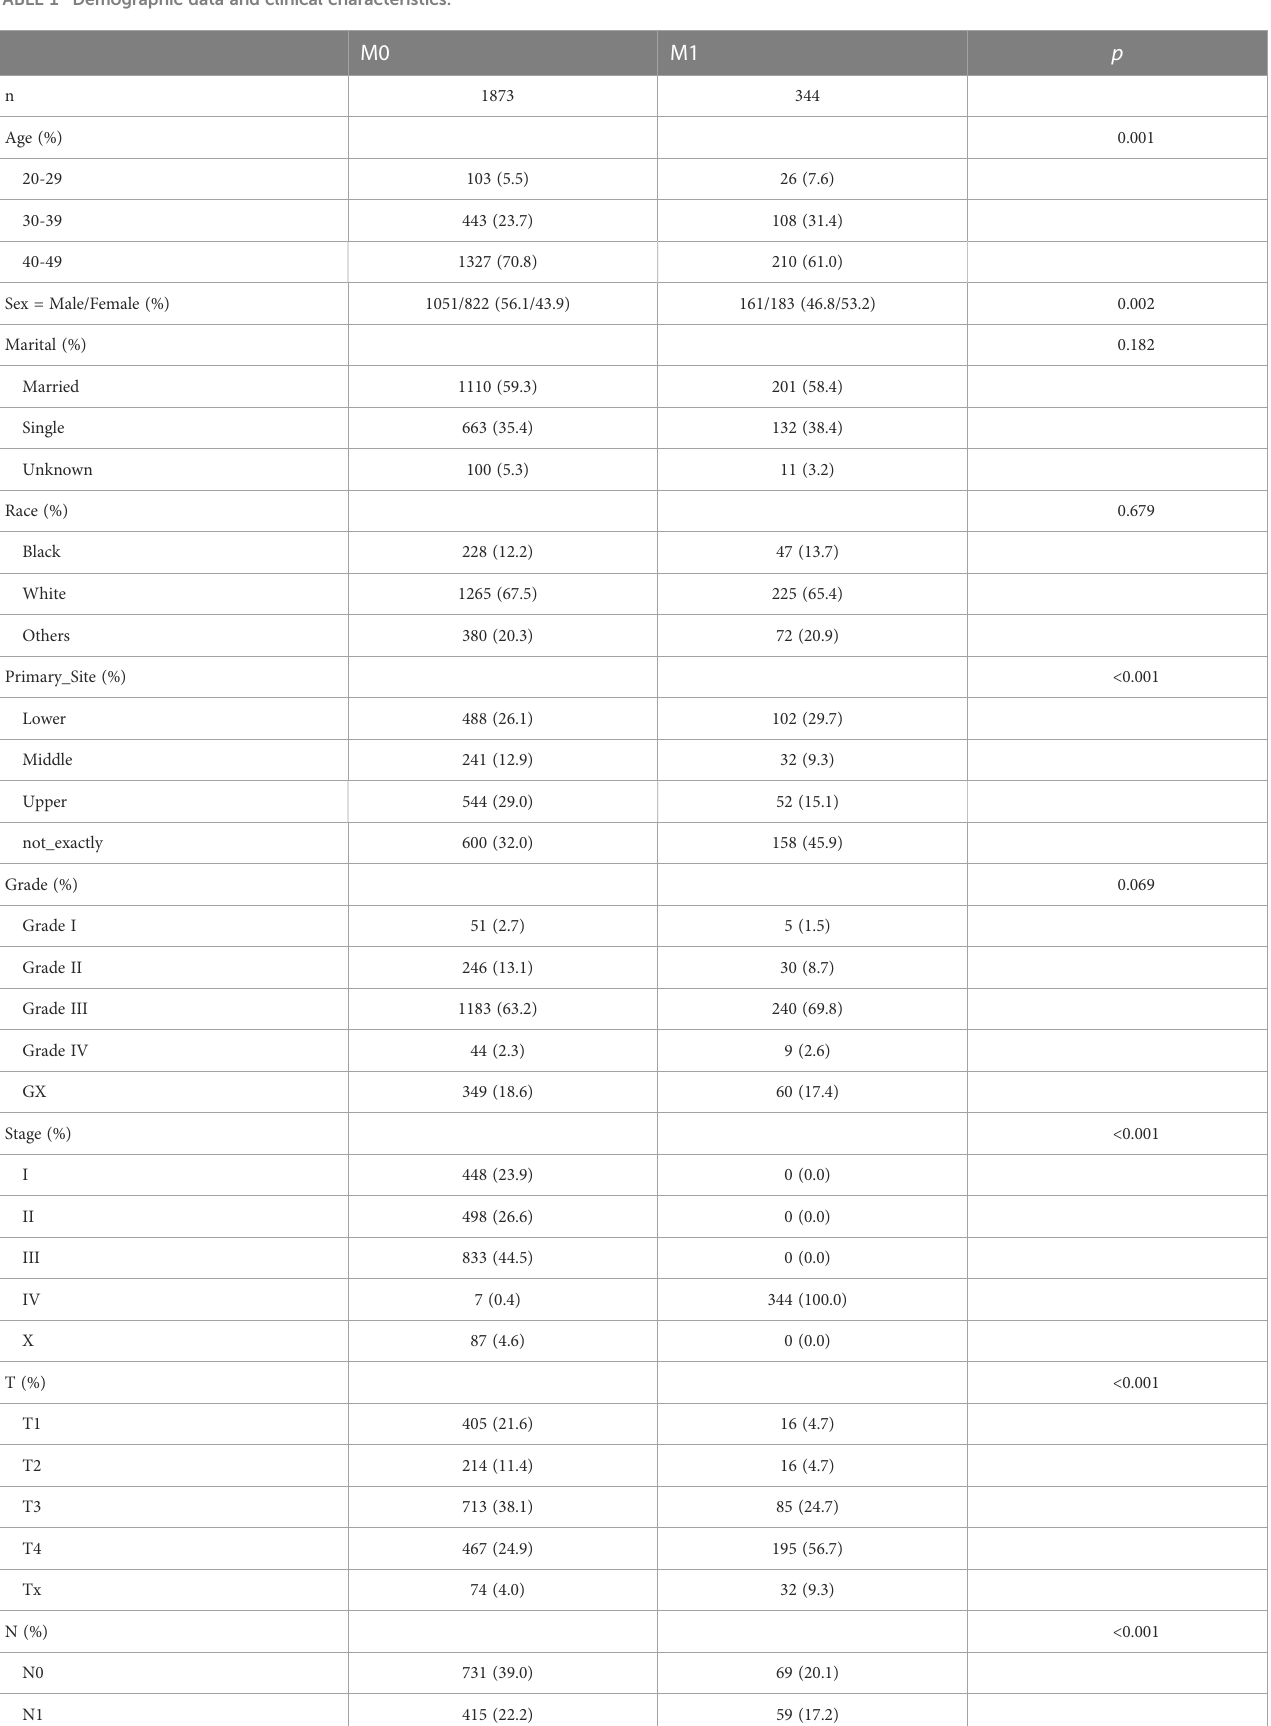
TABLE 1 Demographic data and clinical